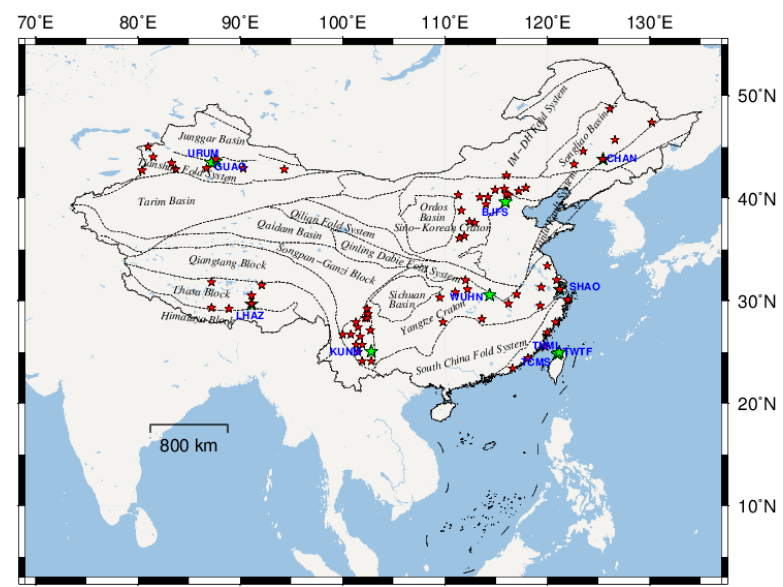
Figure 6. Distribution of eight divided sub-areas according to IGS stations and their surrounding CMONOC stations that are chosen by the criteria proposed in this paper. Table 4. Information of eight divided sub-regions when extracting CMC of IGS stations combining CMONOC stations. Note that GUAO and URUM are in the same sub-region, and three IGS stations in Taiwan (TCMS, TNML and TWTF) are in the same